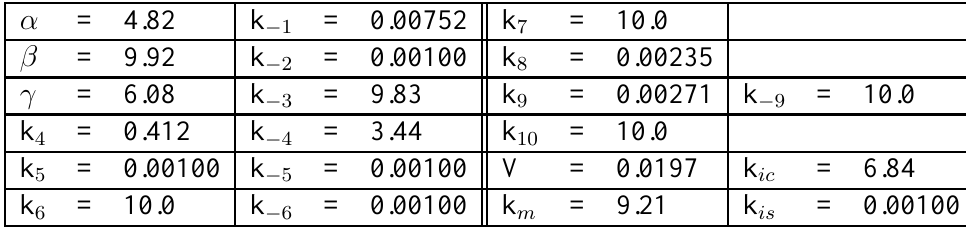
Table 1: Kinetic parameters used for